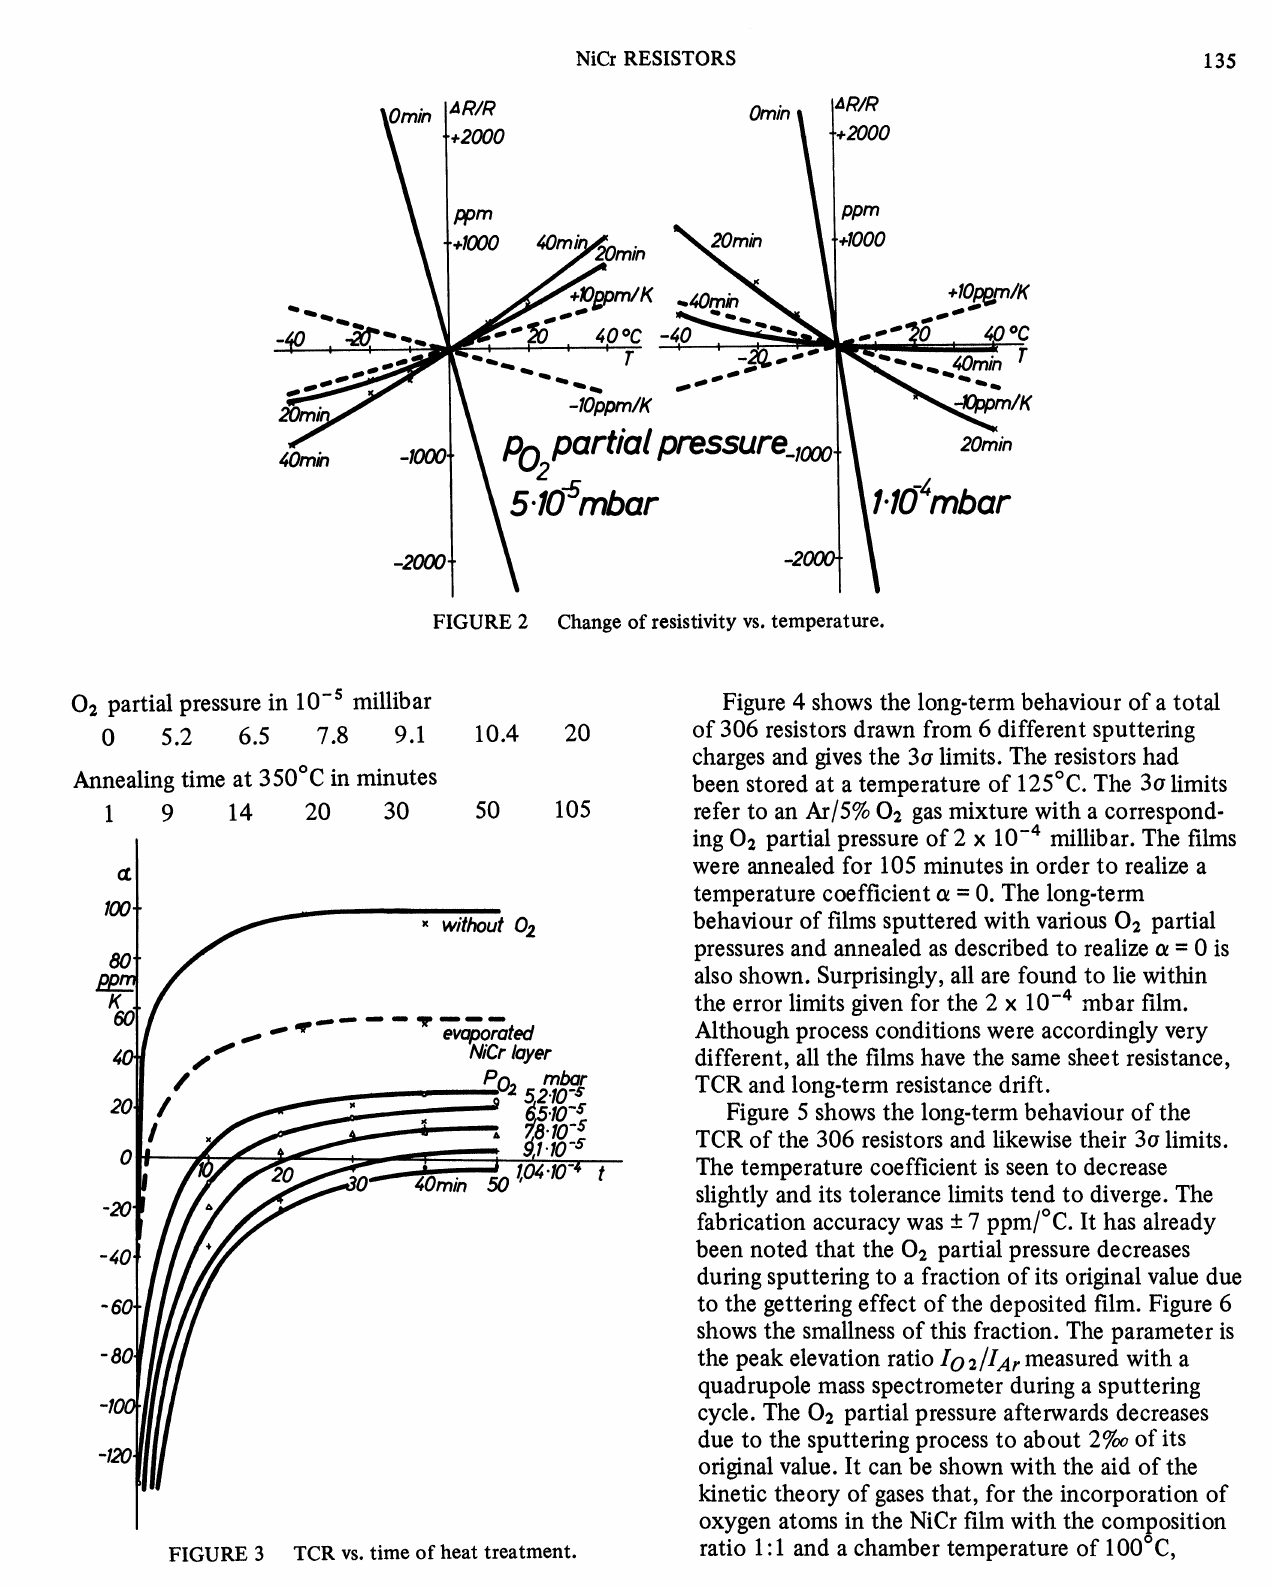
FIGURE 3 TCR vs. time of heat